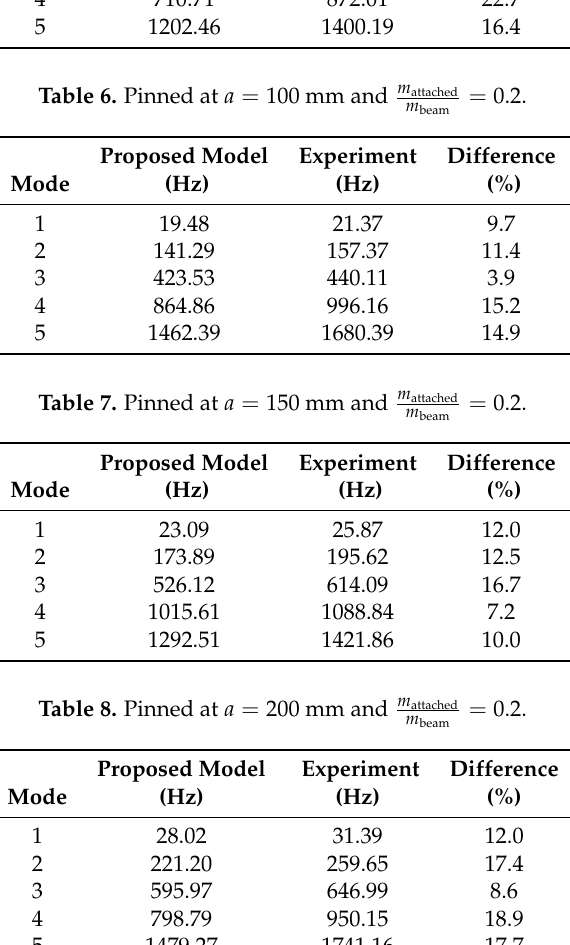
Table 6. Pinned at a = 100 mm and m attached